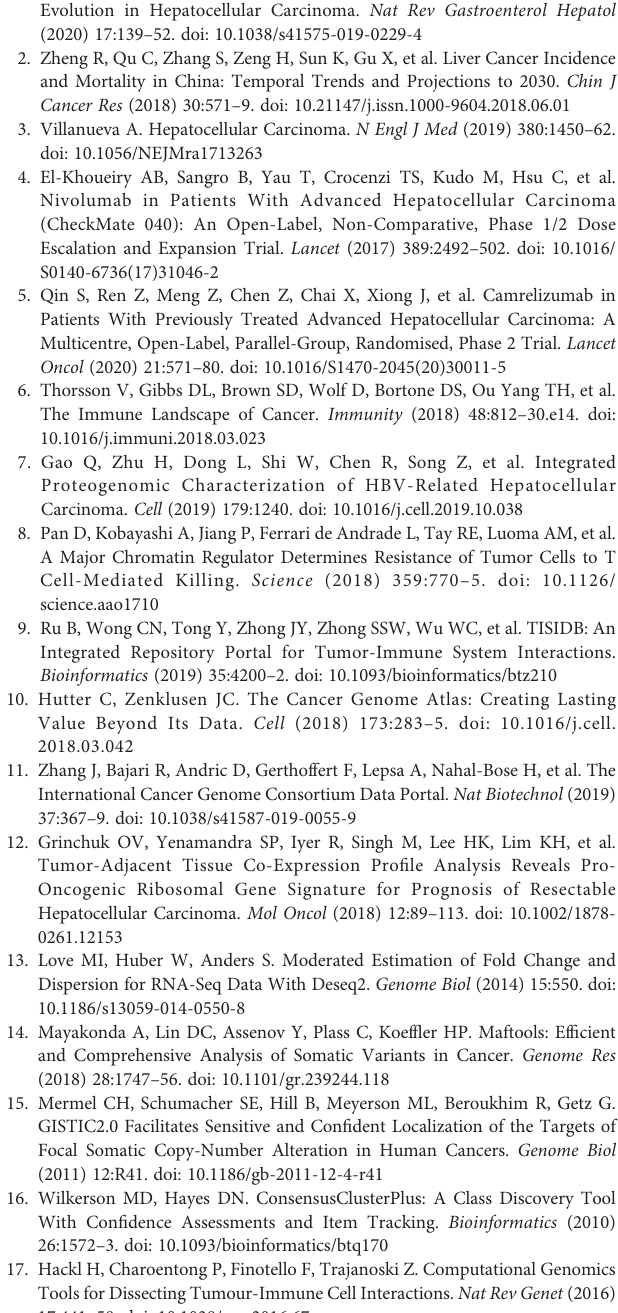
Supplementary Figure 12 | The TCscore was related to clinicopathological characteristicsofpatientswithHCC. (A – G) RelationshipsbetweentheTCscoreand clinicopathological characteristics, such as (A) survival status, (B) gender, (C) TP53 mutations, (D) CTNNB mutations, (E) T stage, (F) grade, and (G) TNM stage, were